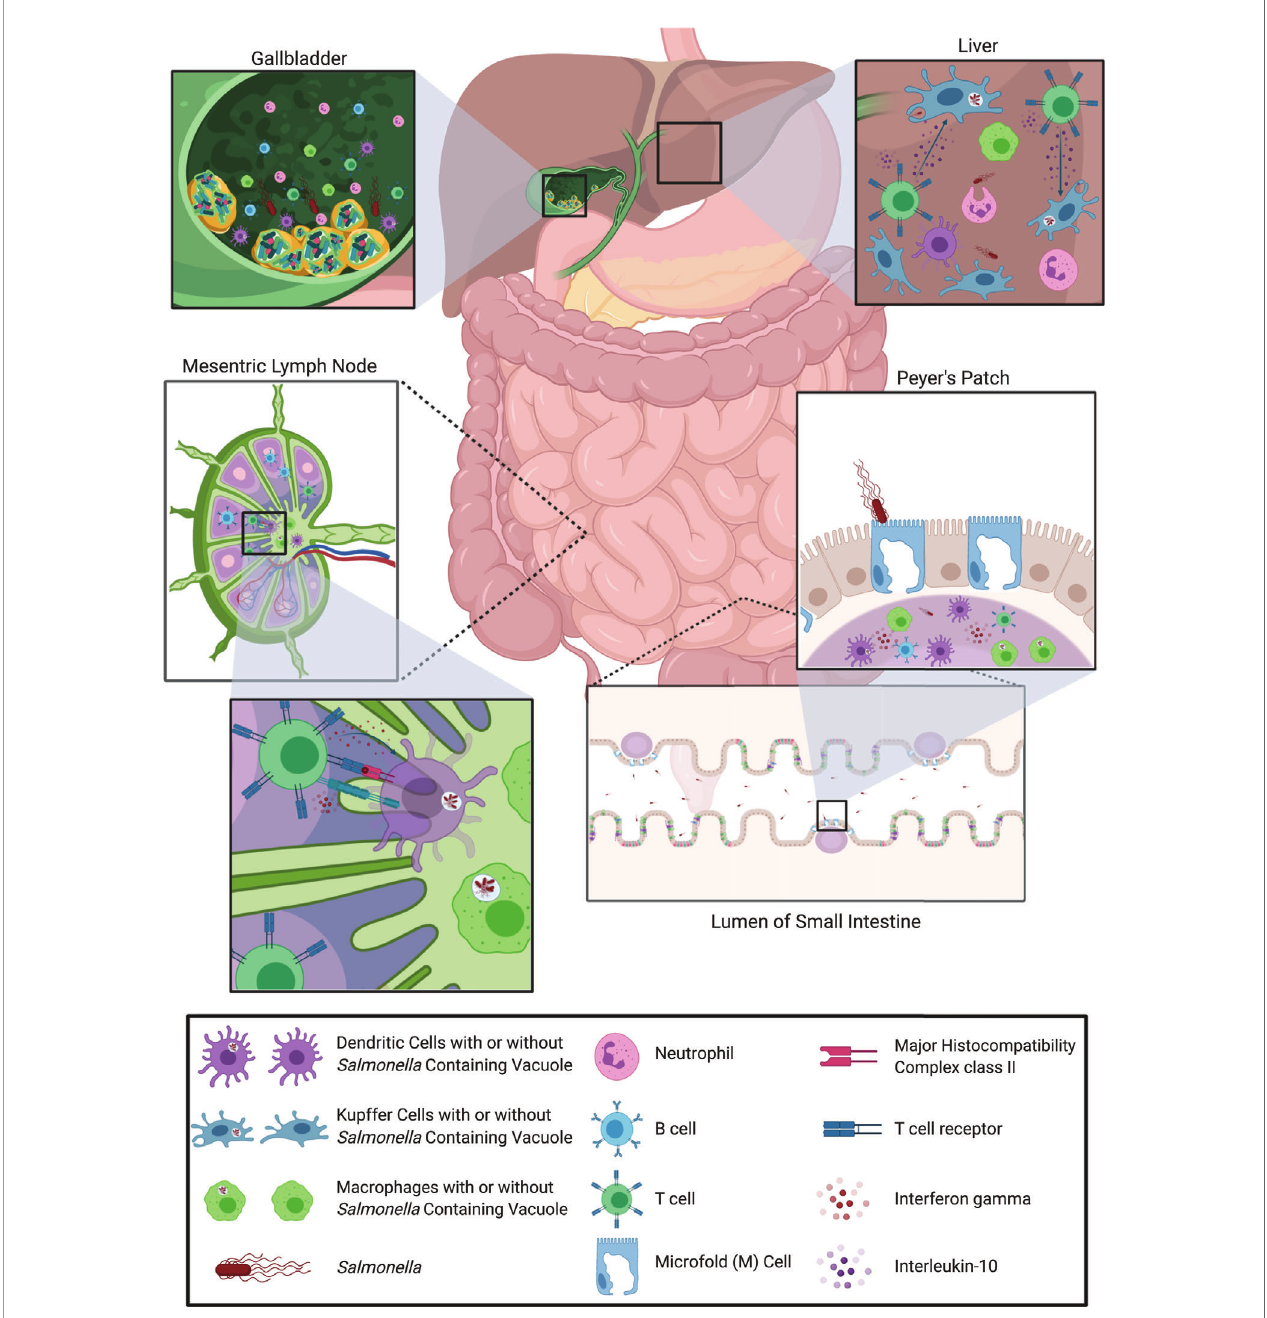
FIGURE 2 | Overview of host immune response to Salmonella infection. Salmonella , infecting via the oral-fecal route, fi rst passes through the stomach and into the lumen of the small intestine. There, Salmonella uses its SPI-1 type III secretion system to preferentially transcytose across M cells to gain access to the Peyer ’ s Patches. Immune cells in the Peyer ’ s Patches, such as macrophages and dendritic cells, sense Salmonella via toll-like receptors and begin to trigger an immune response. Macrophages and dendritic cells then migrate to the gut-draining mesenteric lymph nodes and the spleen (not shown) harboring Salmonella antigens as well as whole bacteria in Salmonella -containing vacuoles. In the lymph nodes and spleen, dendritic cells and macrophages present antigen on MHC class II to activate Salmonella -speci fi c helper T cells which can then subsequently activate Salmonella -speci fi c B cells. These adaptive immune cells then traf fi c back into the intestine to fi ght infection by releasing the antimicrobial cytokine interferon gamma or neutralizing antibodies. Any Salmonella that escape the immune response of the Peyer ’ s patches and mesenteric lymph nodes or spleen, can travel to, and invade, the liver and subsequently the gallbladder via the bile duct. In the liver, Kupffer cells phagocytose Salmonella and activate Salmonella -speci fi c T cells to produce the anti-in fl ammatory cytokine interleukin-10, likely preventing bacterial clearance. The immune environment in the gallbladder is less clear, primarily because of the presence of Salmonella bio fi lms on gallstones, which can hinder/alter the immune response. The liver and gallbladder are both sites where the host can experience chronic infection with Salmonella . Images created with BioRender.com.